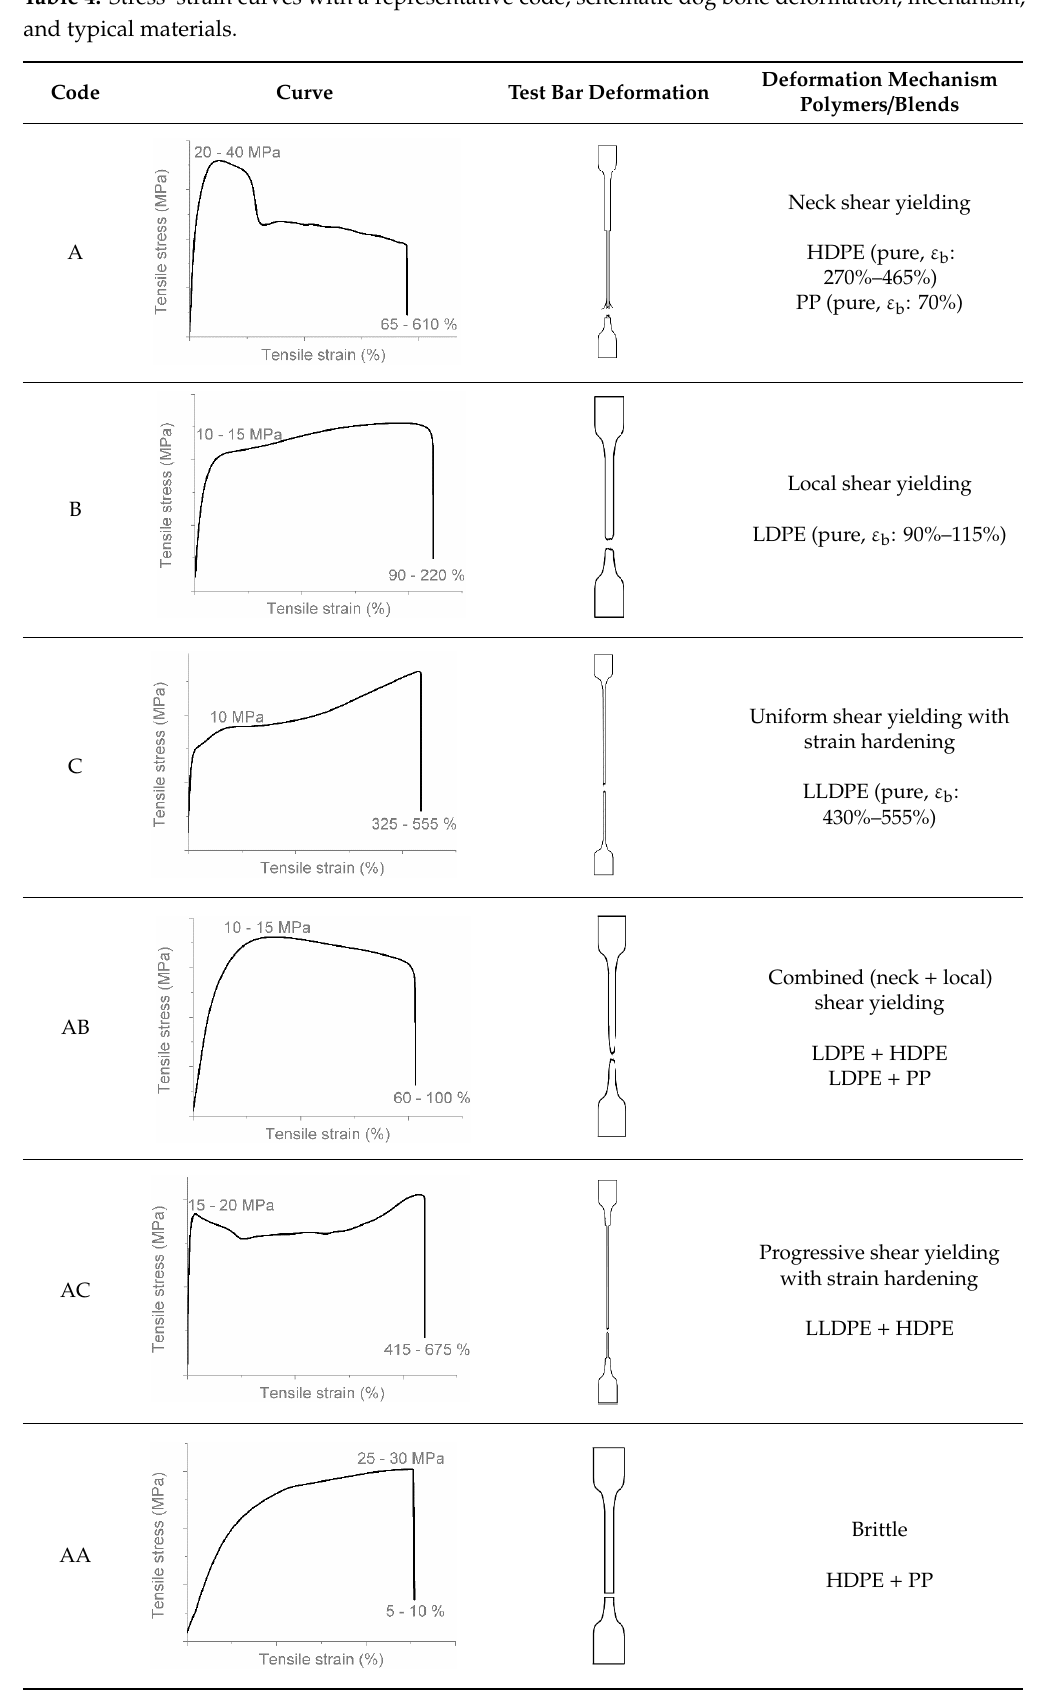
Table 5. Typical deformation curve for each blend, the letter of which corresponds to the deformation mechanisms described in Table 4.